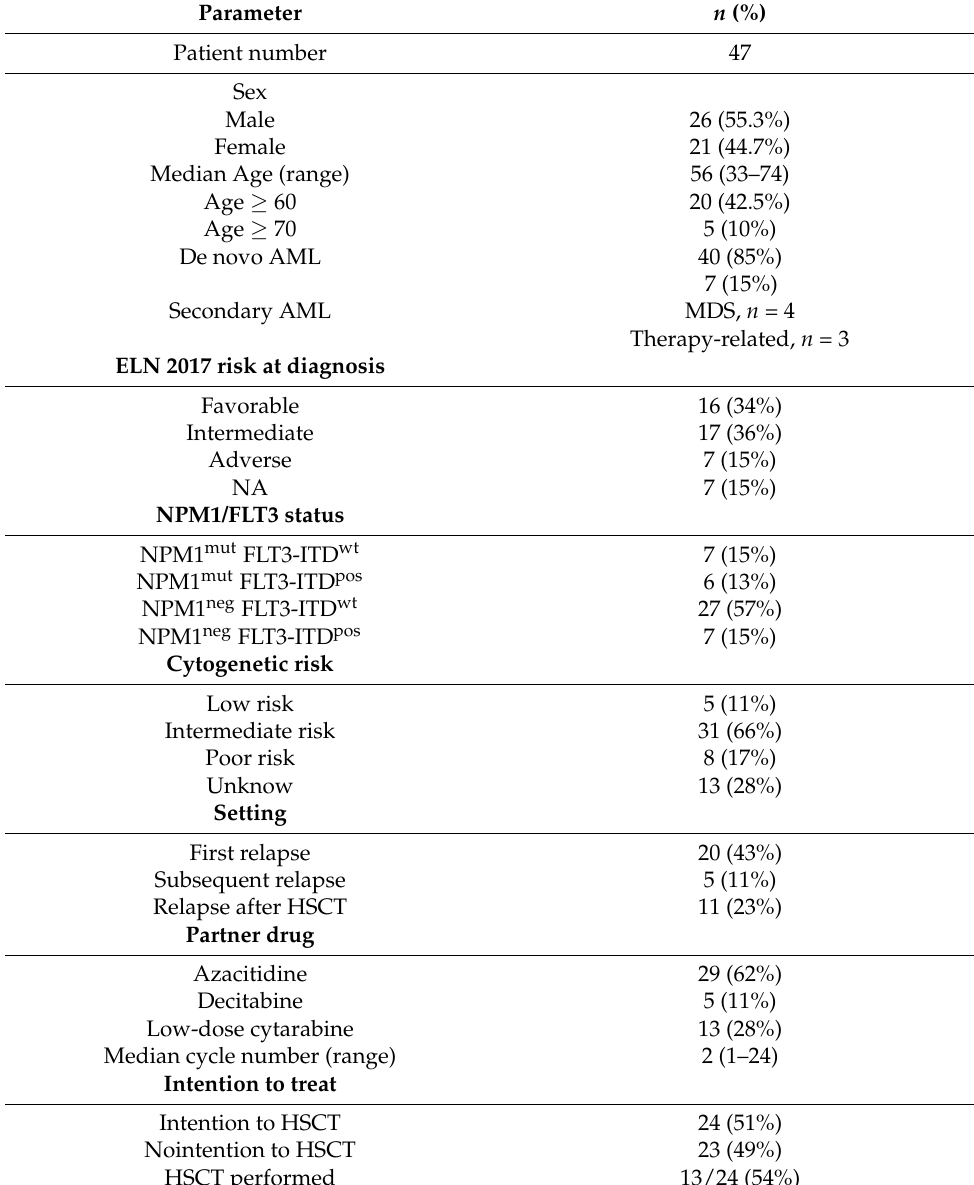
Table 1. Patients’